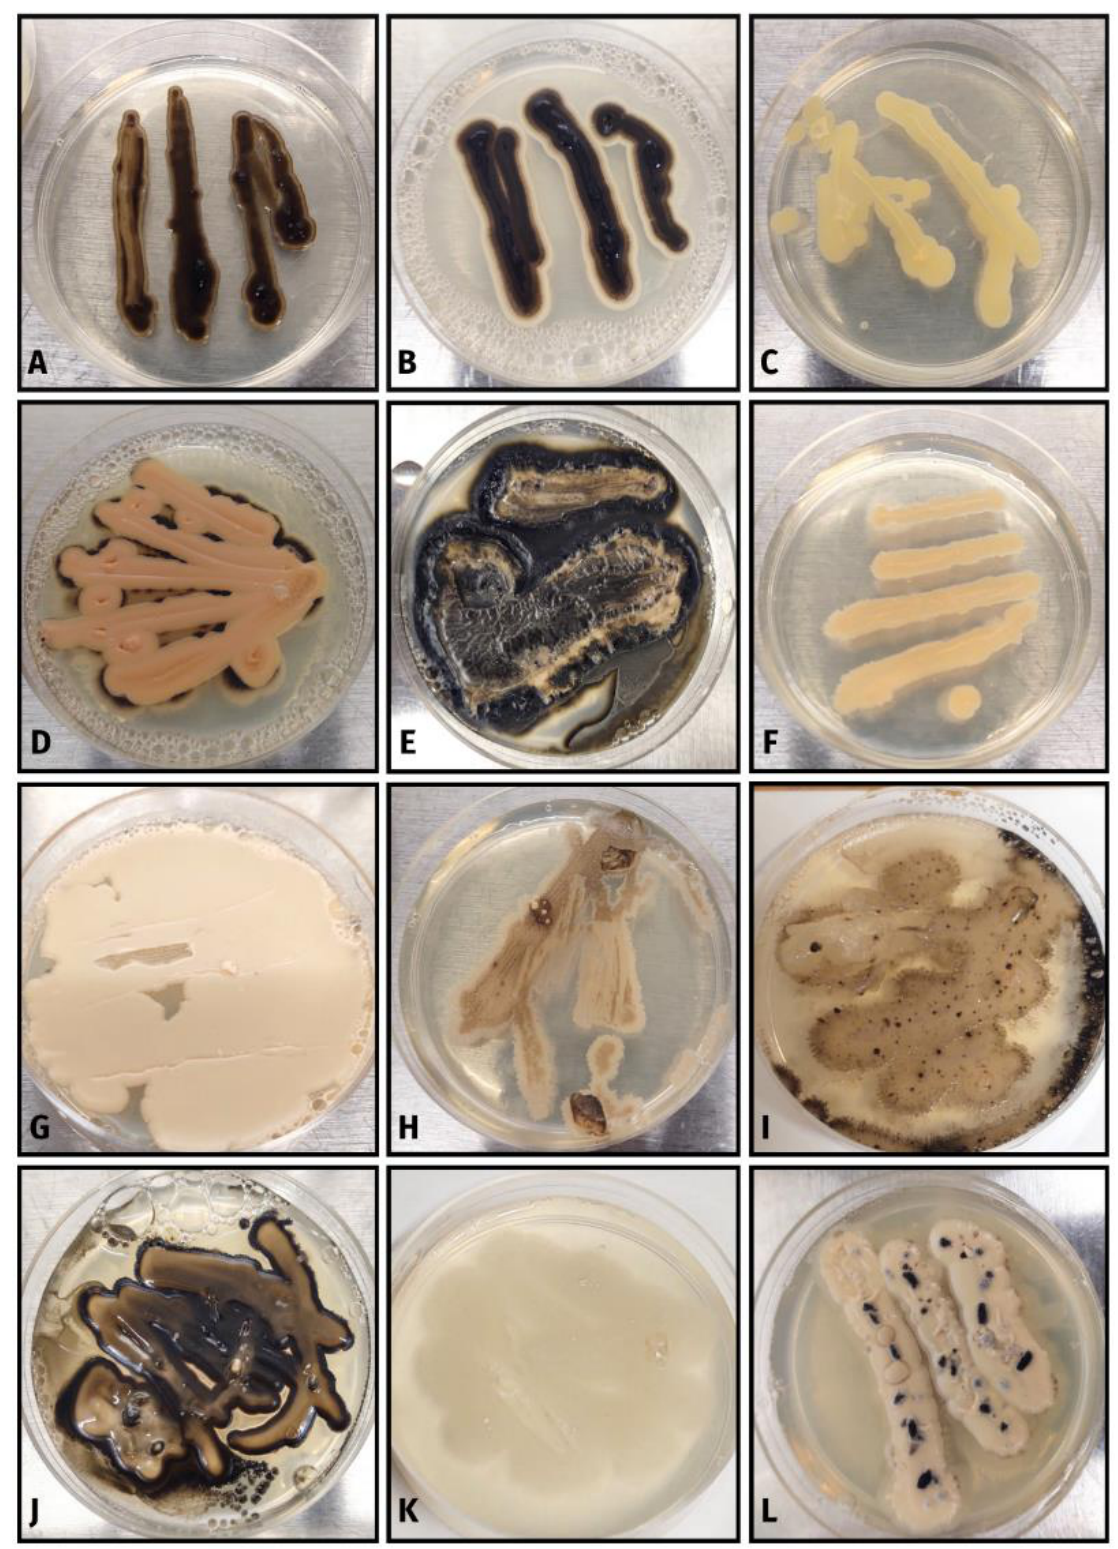
Figure 4. Lichen-associated isolates from the class Dothideomycetes. ( A – C ) Dothiora isolates; ( D , E ) Plowrightia isolates; ( F ) unknown Dothideales isolate; ( G – L ) Aureobasidium isolates.